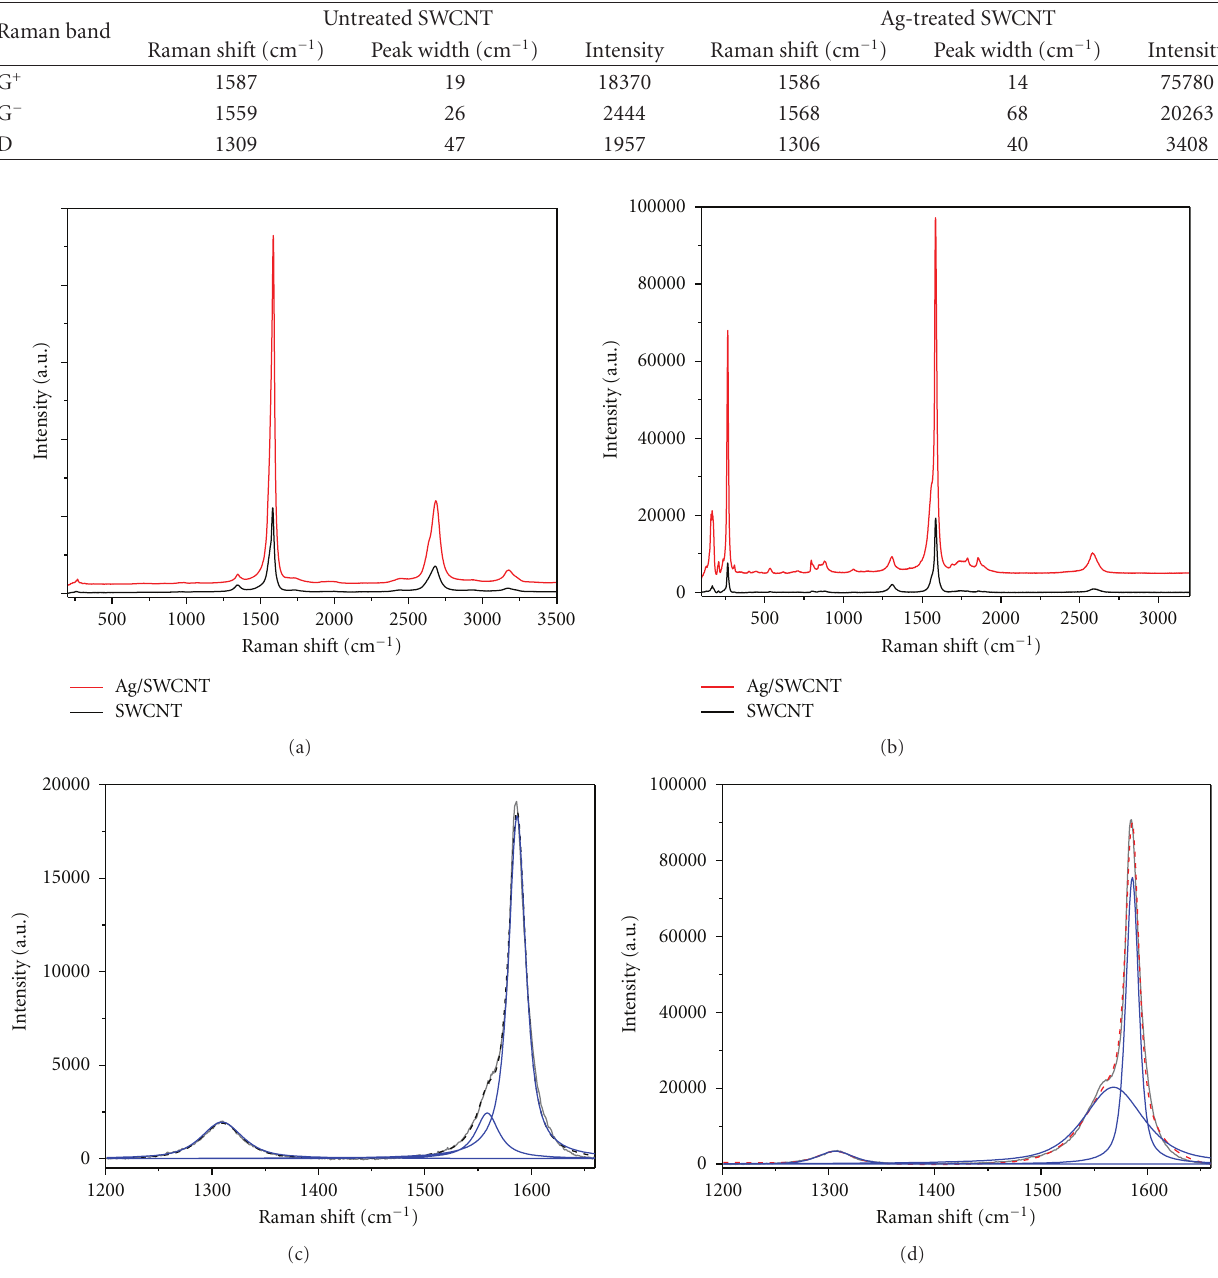
Figure 2: Raman spectra untreated SWCNT and Ag-treated SWCNT using (a) 2. 41eV (b) 1.58 eV laser excitation. The laser power measured at the sample was 1mW for (a) and 0.4mW for (b). Curve fitting of D and G bands for (c) SWCNT and (d) Ag treated